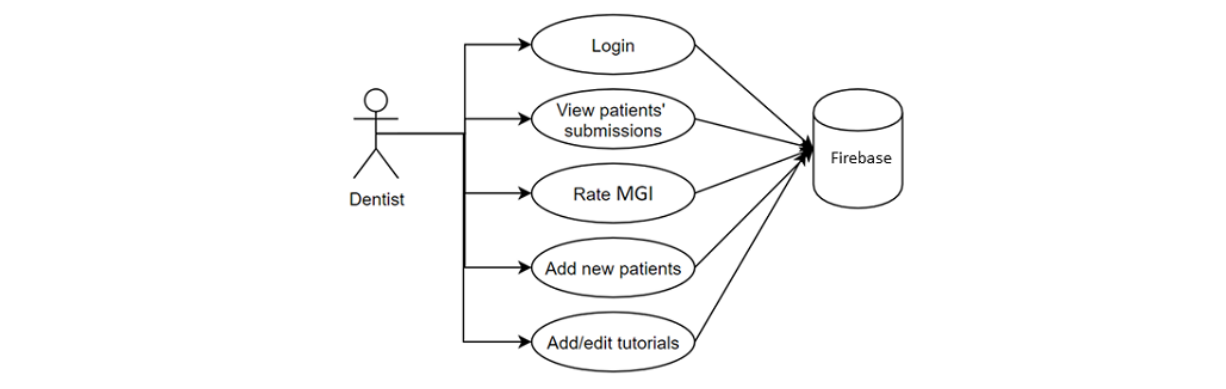
Figure 3. Dentist use cases.